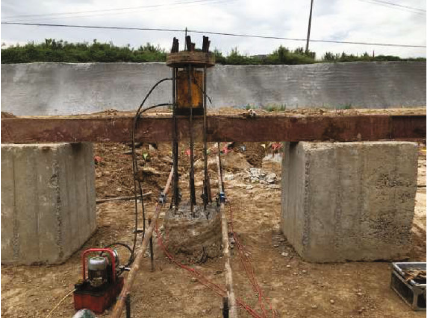
Figure 4: Layout plan of test piles.